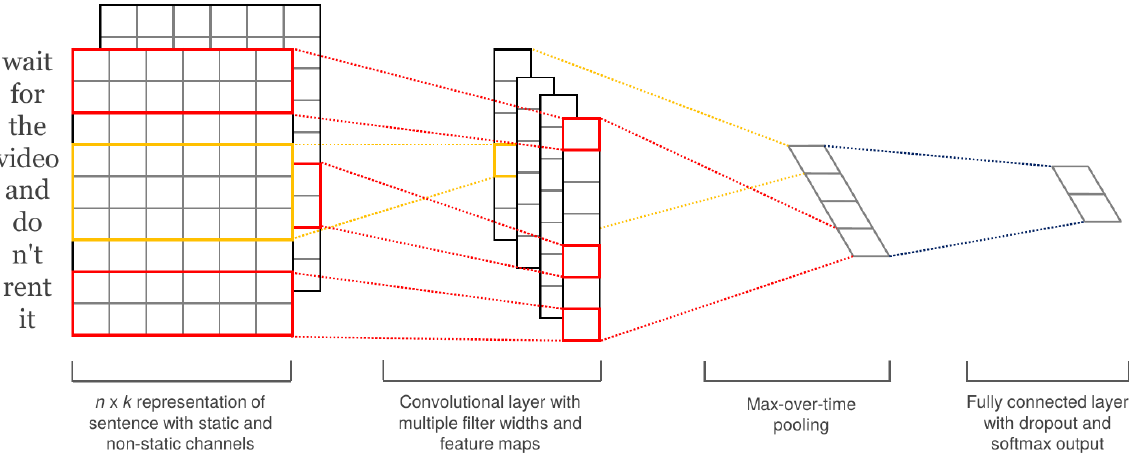
Figure 2. CNN for text classification as proposed by Kim